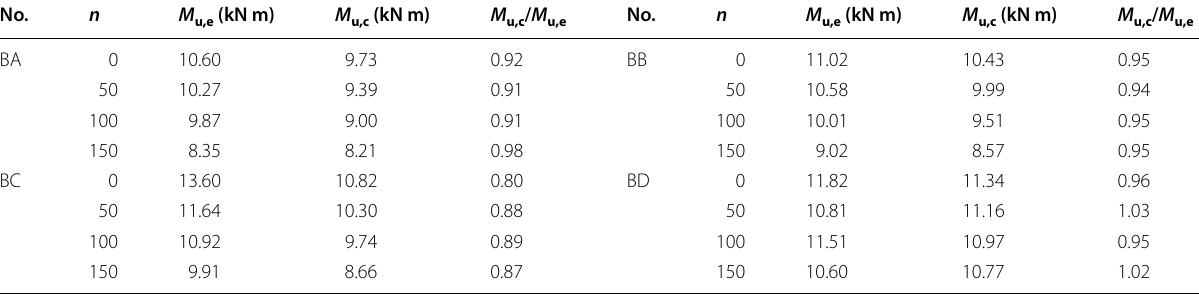
Table 12 Comparison of tested and predicted bending capacities